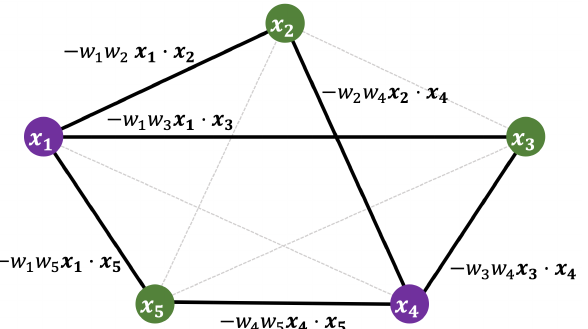
Figure 1. Weighted Max-Cut for a coreset consisting of five points. Given an assignment of vertices to two colors, i.e., a cut, we are interested in the sum of − w i w j x i · x j on edges crossing the cut. By interpreting these terms as edge weights, we seek a weighted